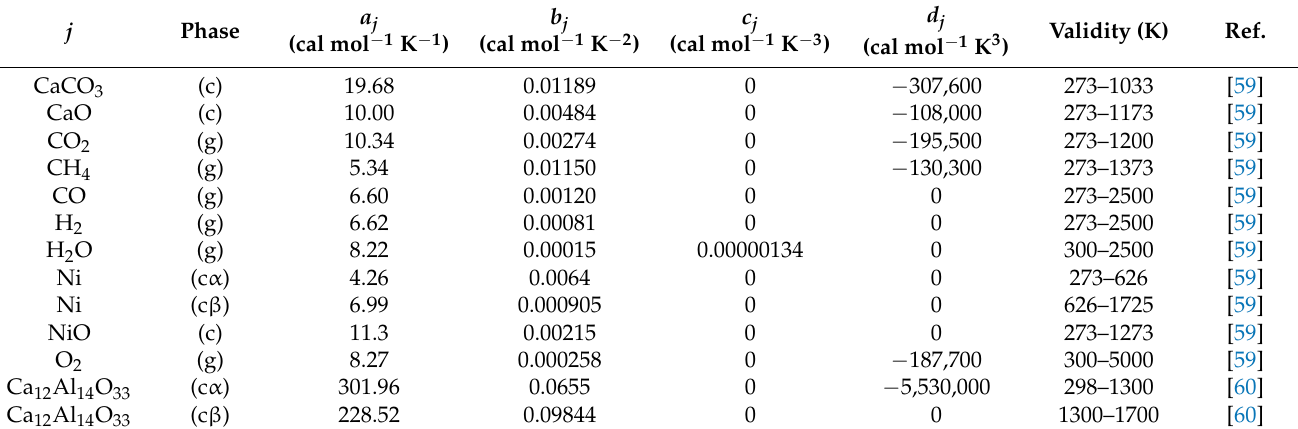
Table A1. Constants for c p,j calculation as a function of absolute temperature, according to A1 (phases: (c) = crystalline; (g) =